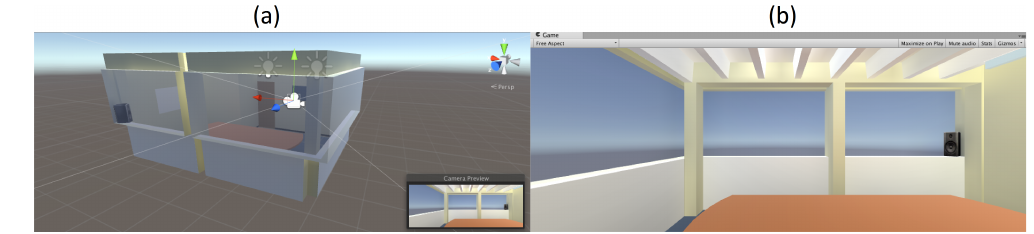
Figure 18. Room model created in Unity. Exterior ( a ) and interior ( b ) view of